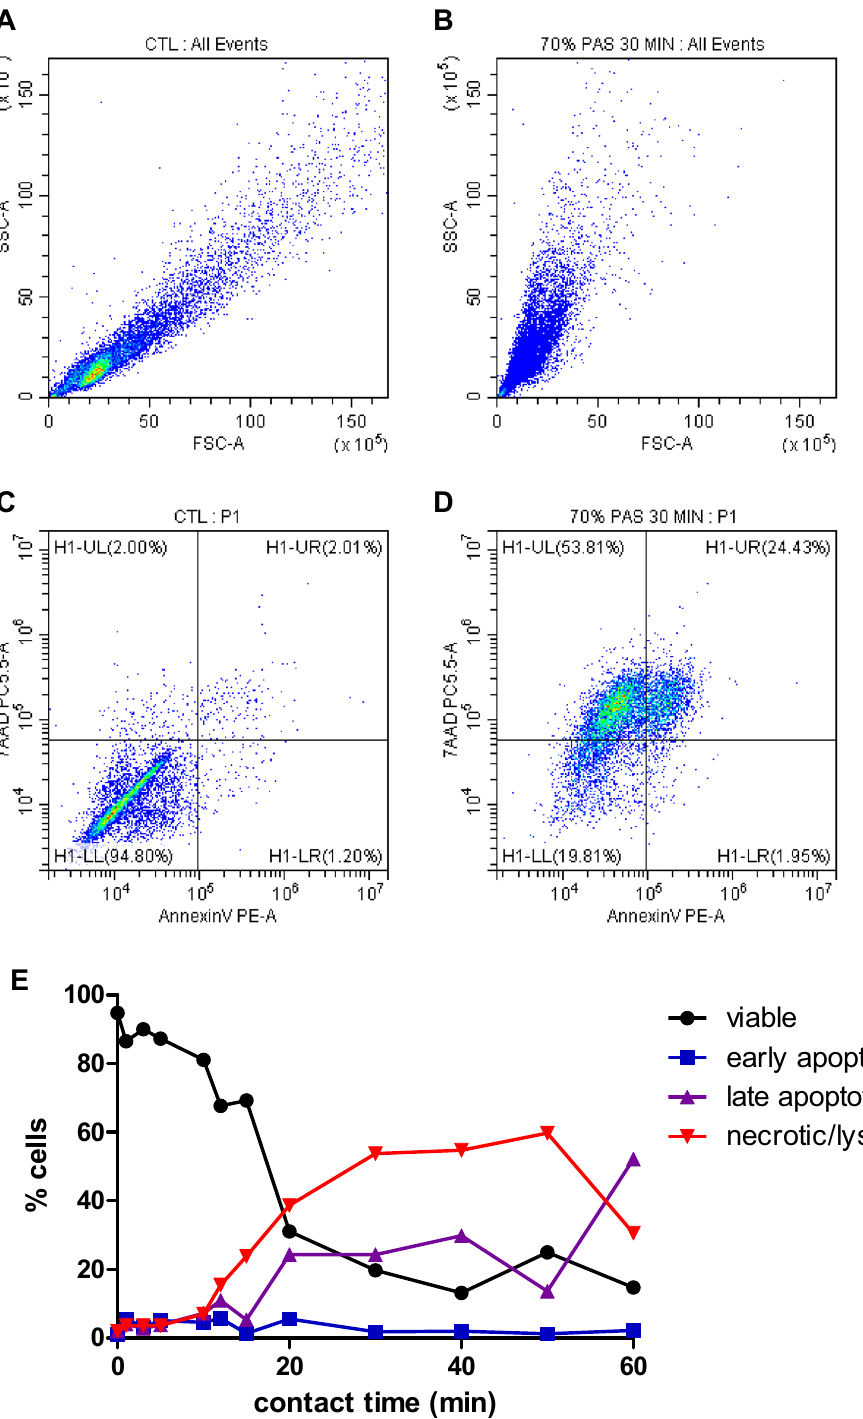
Figure 6. Apoptosis and lysis of HaCaT cells after incubation with 70% PAS at different contact times assessed using AnnexinV and 7AAD staining and flow cytometric analysis. Representative flow cytometry images showing FSC/SSC for control ( A ) and cells treated with 70% PAS for 30 min ( B ) and AnnexinV/7AAD staining for control ( C ) and 70% PAS 30 min ( D ). Representative progression of apoptosis/lysis over contact time is shown in E (viable: AnnV−/7AAD−, early apoptotic: AnnV+/7AAD−, late apoptotic: AnnV+/7AAD+, necrotic/ lysed: